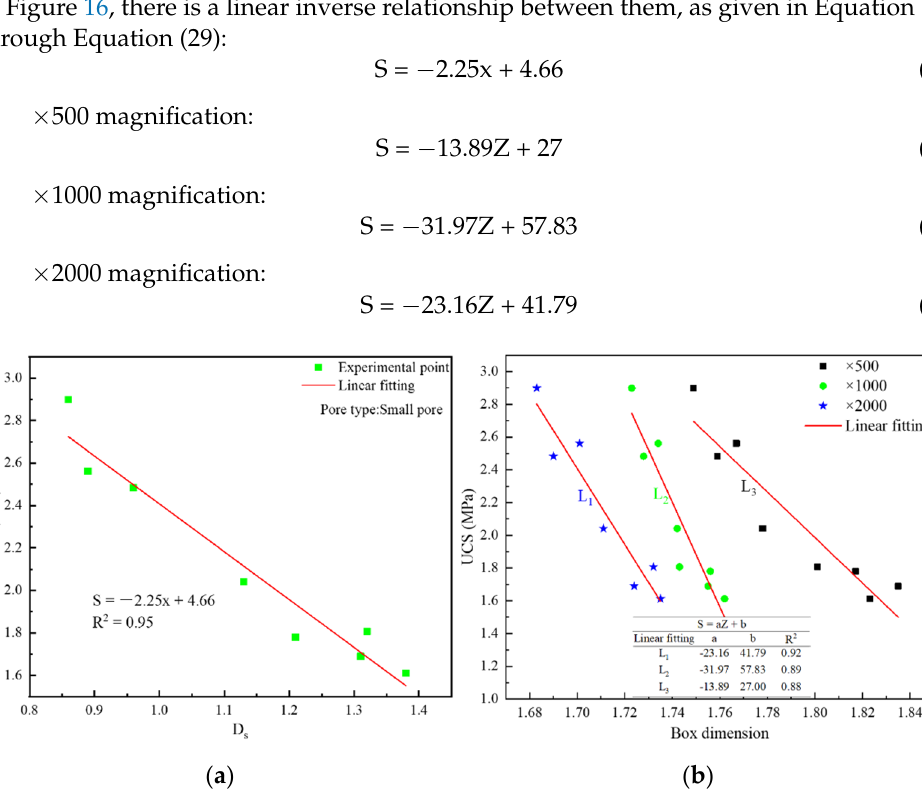
Figure 16. The functional relationship between strength and dimension. ( a ): Relationship between UCS and small pore NMR-FT fractal dimension( b ): Relationship between UCS and SEM-FT box dimension